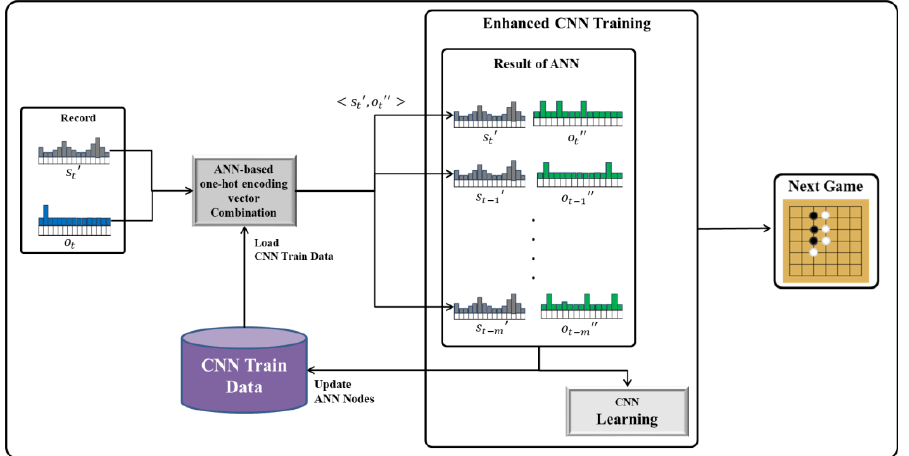
Figure 3. Enhanced convolutional neural networks (CNN) training.